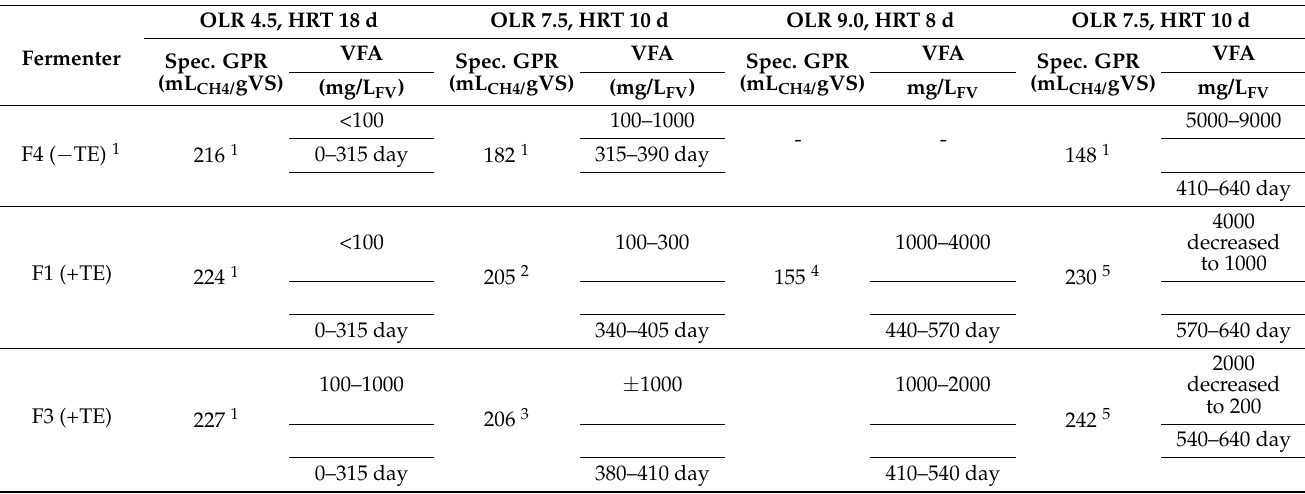
Table 6. Specific methane production (spec GPR) of three fully automatic, continuously stirred mesophilic (41 ◦ C) fermenters. They were fed with wheat straw, as the sole substrate, at different loading rates in ‘synthetic manure’ and supplemented with trace elements, according to Figures 2 and 3. Reference fermenter F4 was not supplemented. All values were converted into mL under standard conditions of temperature and pressure and related to VS (thereby, approx. 10% reduced, with respect to raw gas measurement). The OLR/HRT-values of fermenter F3 were according to Figure 3. Therefore, column 4 refers to fermentation period 3 for F3 and not to period 5, as for